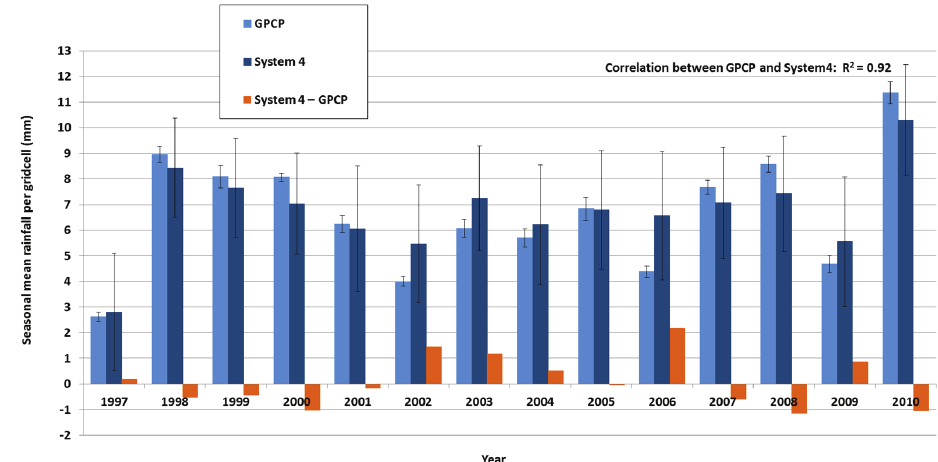
Figure 5. Southern Kalimantan: seasonal mean GPCP rainfall per grid cell vs. seasonal mean System 4 rainfall per grid cell. The edges of the GPCP whiskers refer to the 5th and 95th percentiles ( ± 1.96 × SE mean ). The upper edge of the System 4 data point whiskers is mean upper tercile –mean middle tercile , and the lower edge of the System 4 whiskers is mean middle tercile –mean lower tercile (refer to data prepa- ration in Methods).